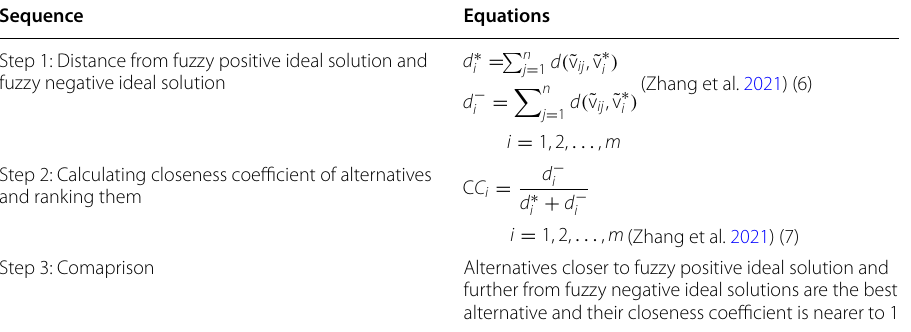
Table 8 Sequences and equations to calculate fuzzy positive ideal solution and fuzzy negative ideal